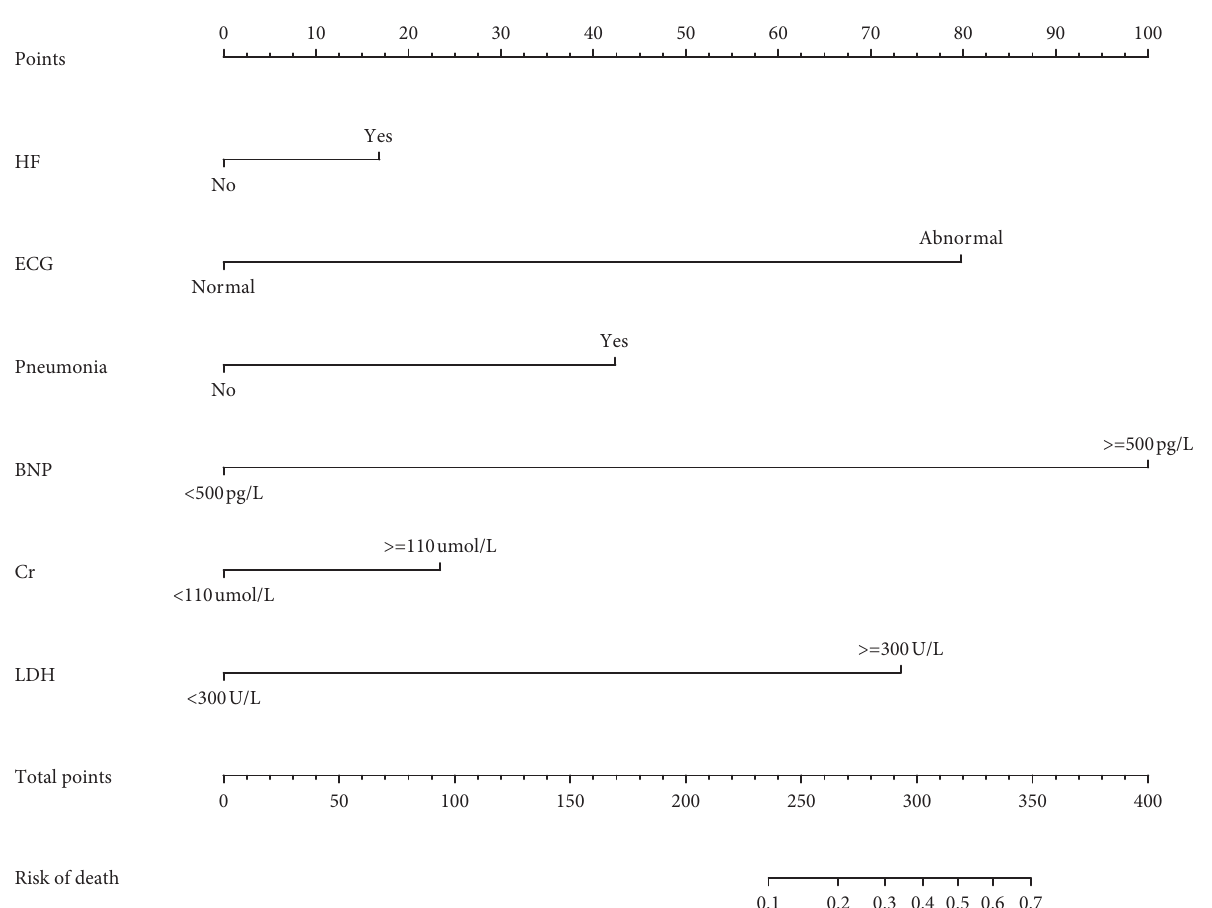
Figure 3: The nomogram for preoperative prediction of early death in viral myocarditis (VMC)